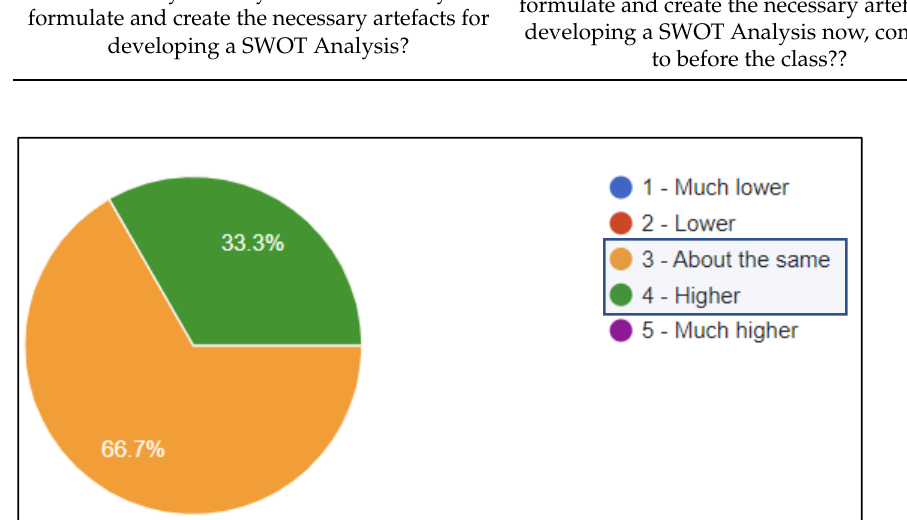
Figure 6. Students’ analysing skills before 1st smart classroom activity (Subject 1).